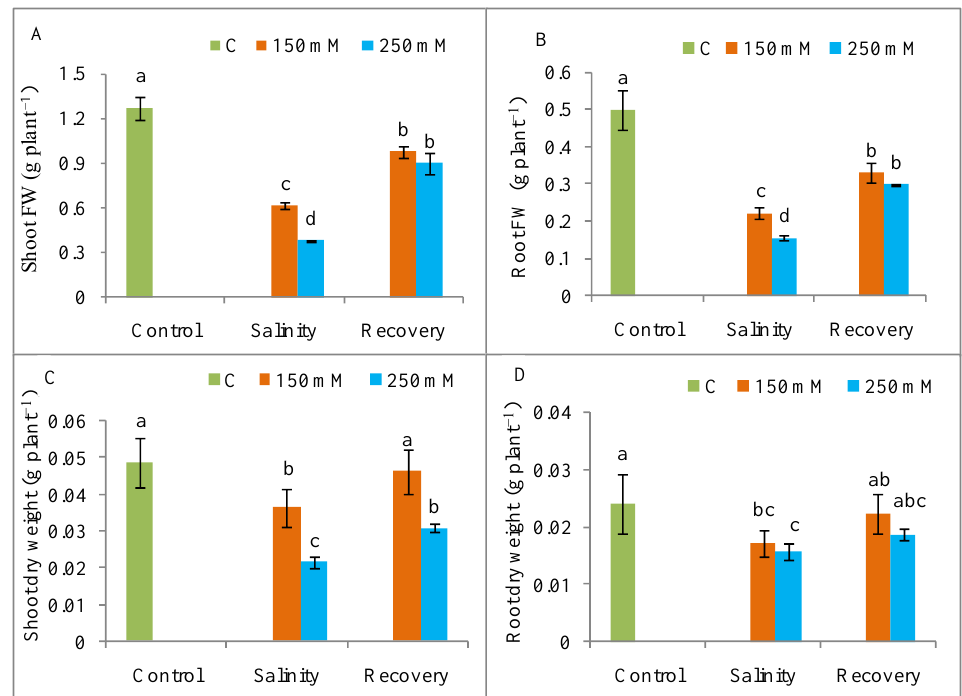
Figure 2. Plant biomass content ( A ) shoot fresh weight, ( B ) root fresh weight, ( C ) shoot dry weight, and ( D ) root dry weight in tomato plants under salinity (150 and 250 mM NaCl) and after a 48 h recovery period. Data means (±SD) were calculated from three replications. Statistically significant values are indicated by dissimilar letters (Fisher’s LSD test, P ≤ 0.05).